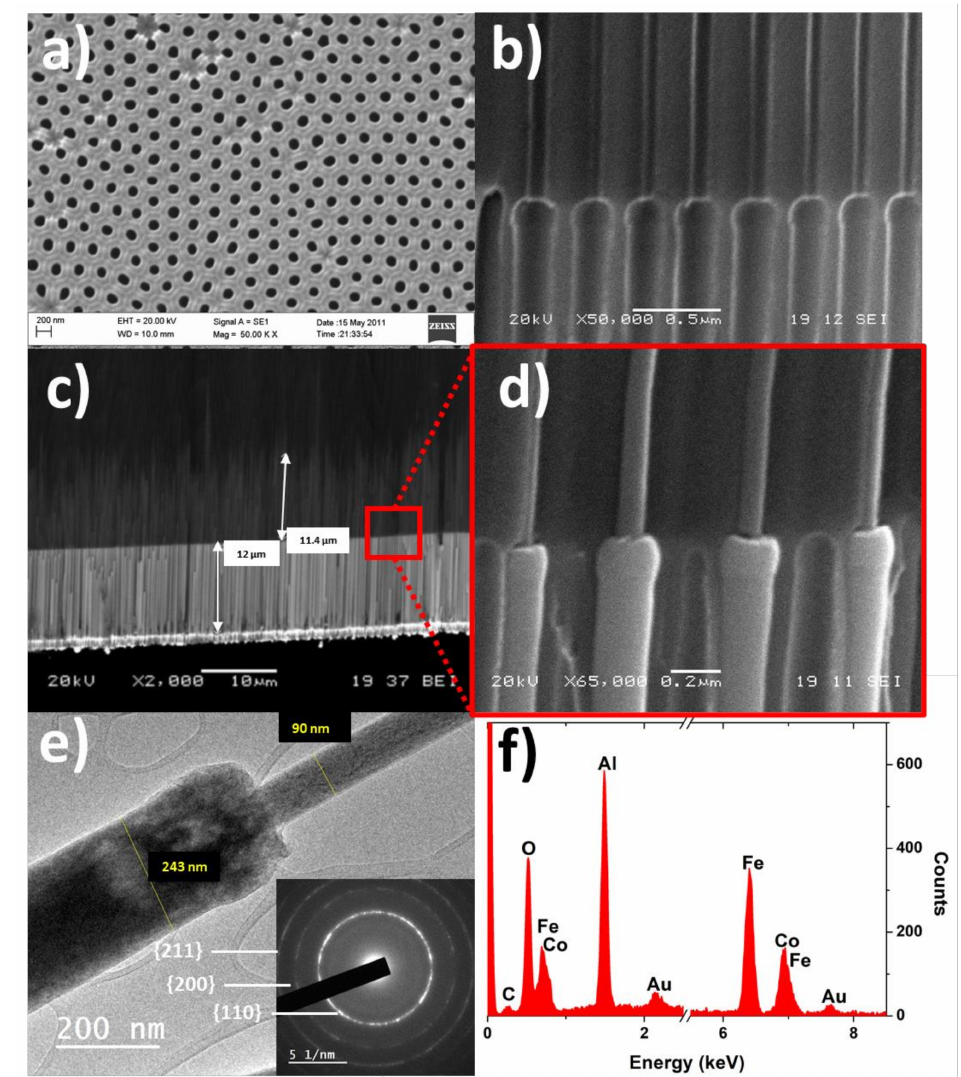
Figure 2. ( a ) SEM micrograph of the patterned nanoporous Al 2 O 3 membrane top view and ( b ) cross-section. ( c ) SEM cross-section of the electrodeposited nanowires where the lengths of different segments can be estimated. ( d ) Magnified SEM cross-section image of the bisegmented nanowires array at the transition of the diameter modulation. ( e ) TEM image of a diameter modulated Fe 67 Co 33 nanowire (inset: SAED pattern measured on a single Fe 67 Co 33 nanowire). ( f ) EDX spectrum performed in the bisegmented FeCo nanowire array embedded into the alumina